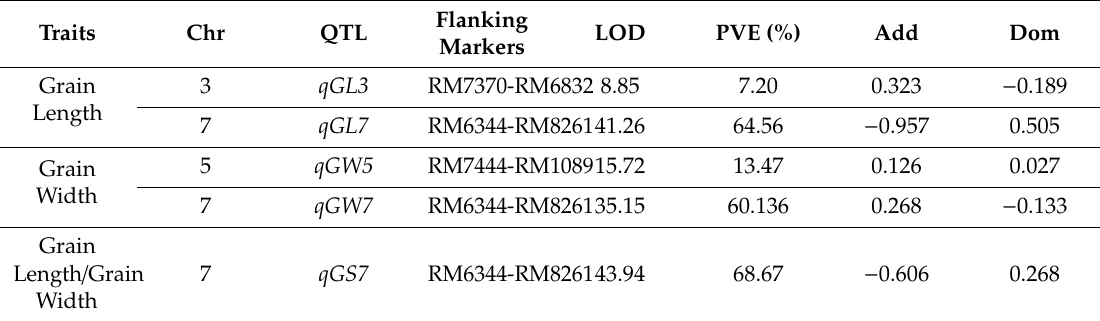
Table 1. QTL detected in a BC 1 F 4 line (RHL2401).